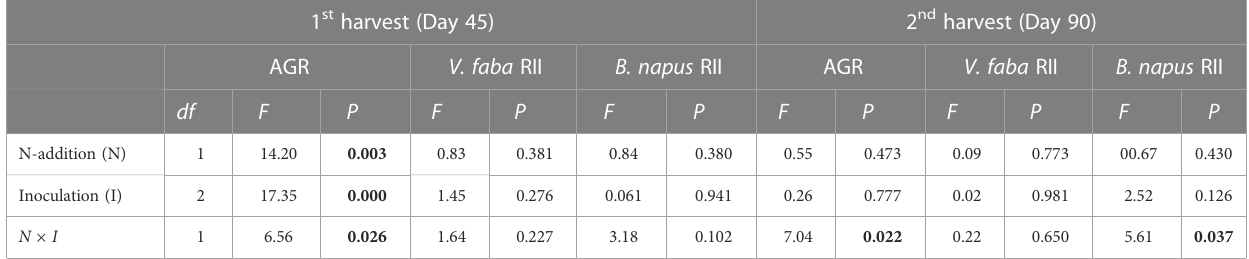
TABLE 3 Effects of AMF inoculation and N-addition on the aggressivity index (AGR) and relative interaction intensity indices (RII) for V. faba and B. napus . 1 st harvest (Day